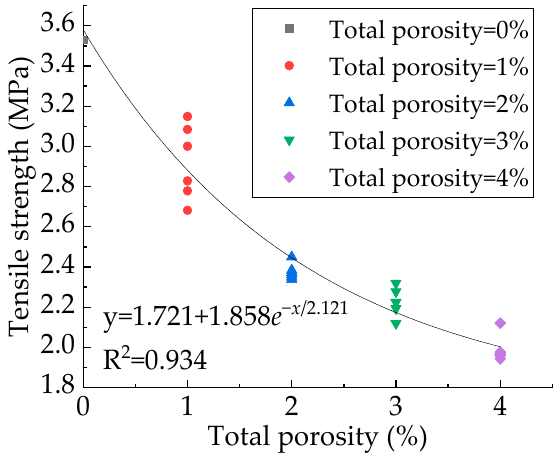
Table 5. Fitting results of the relationship between total porosity and tensile strength.